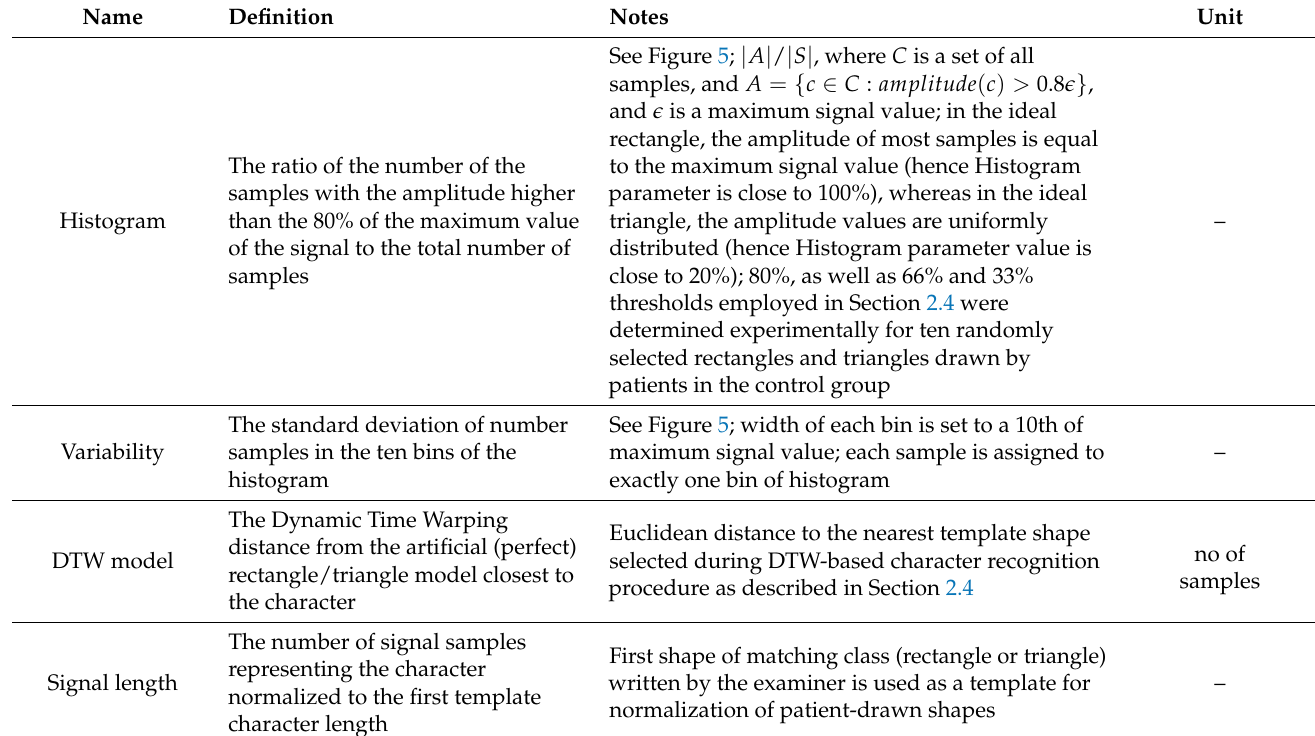
Table A2. Signal-related features.